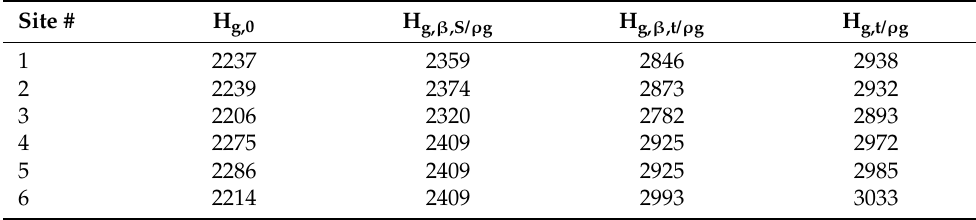
Table 2. Maximum annual solar energy sums for the 82 sites in Saudi Arabia for flat-plate solar collectors that are: horizontal (H g,0 ), mode (i) static (H g, β ,S/ ρ g ), mode (ii) dynamic (H g, β ,t/ ρ g ), and mode (iii) dynamic (H g,t/ ρ g ) derived by using a ground albedo of ρ g , under all-sky conditions in the period 2005–2016. The H g values are rounded integers in kWhm − 2 year − 1 . Site # H g,0 H g, β ,S/ ρ